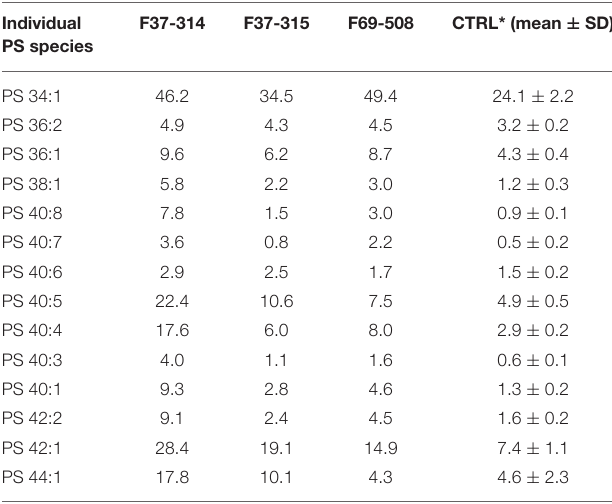
TABLE 2 | Phosphatidylserine molecular species in fibroblasts derived from the patients F69-508, F37-314, and F37-315 and two unrelated healthy controls. Individual PS species